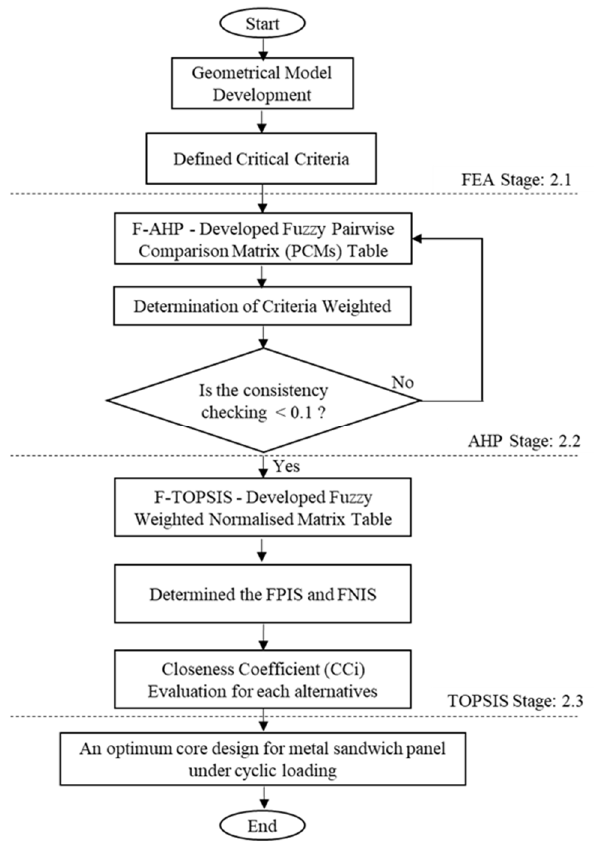
Figure 1. The overall study process flow.